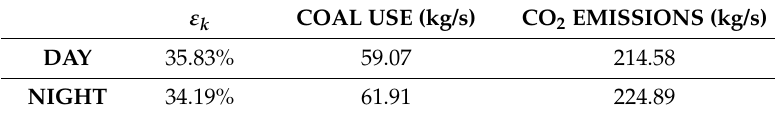
Table 2. Comparison between the operation of the hybrid power plant during night and day. ε k COAL USE